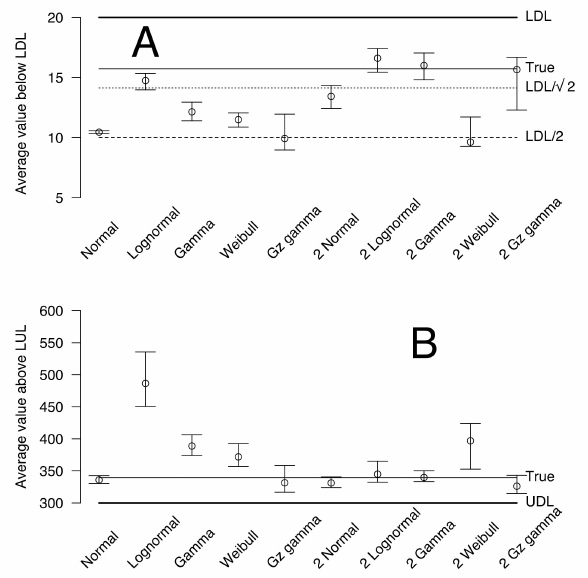
Figure 4. Average and 95% credible interval of the fitted values below the lower detection limit (LDL) ( A ) and above the upper detection limit (UDL) ( B ) fictive distributions. The models are shown on the x -axis, and the corresponding fitted values are shown on the y -axis. The true value based on the distribution used to generate the data is shown on the right, along with the usual LDL /2 and √ LDL / 2 values for LDL